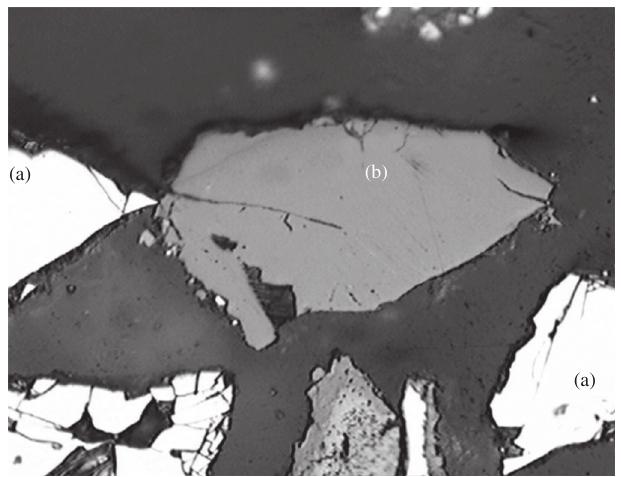
Figure 4. Optical Micrograph of a slag particle liberated from the HC-FeMn alloy. 220 x . a) alloy, and b)